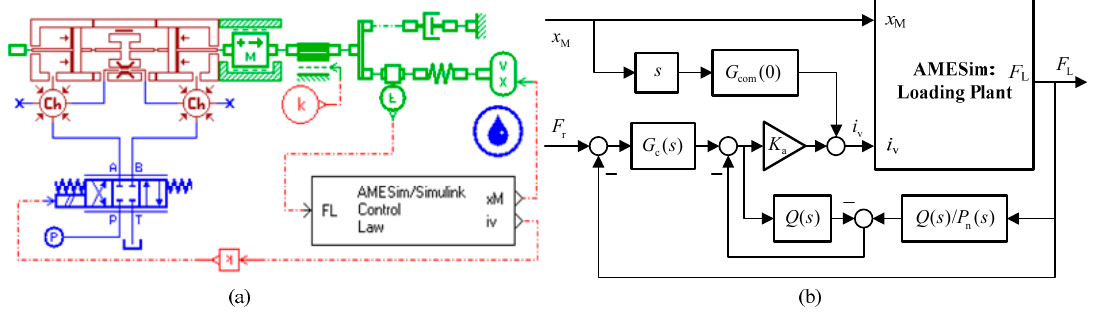
Figure 15. Schematic diagrams of co-simulation: ( a ) AMESim block diagram; and ( b ) co-simulation in MATLAB/Simulink.